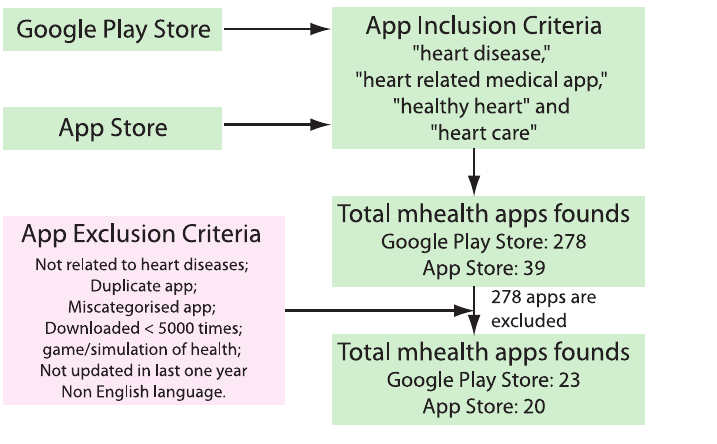
Fig 9. Case study design and app selection flowchart.